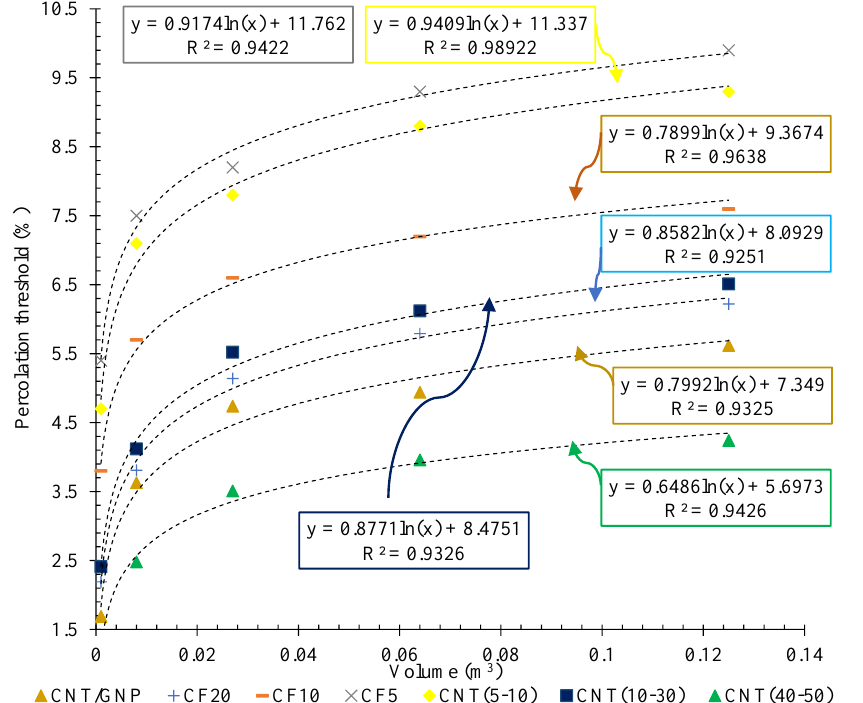
Figure 15. The percolation threshold vs. matrix volume (surrounded between electrodes) for the different CF and CNT reinforced specimens.